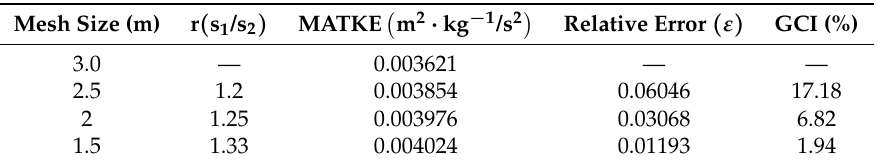
Table 3. Grid convergence index (GCI) calculation.